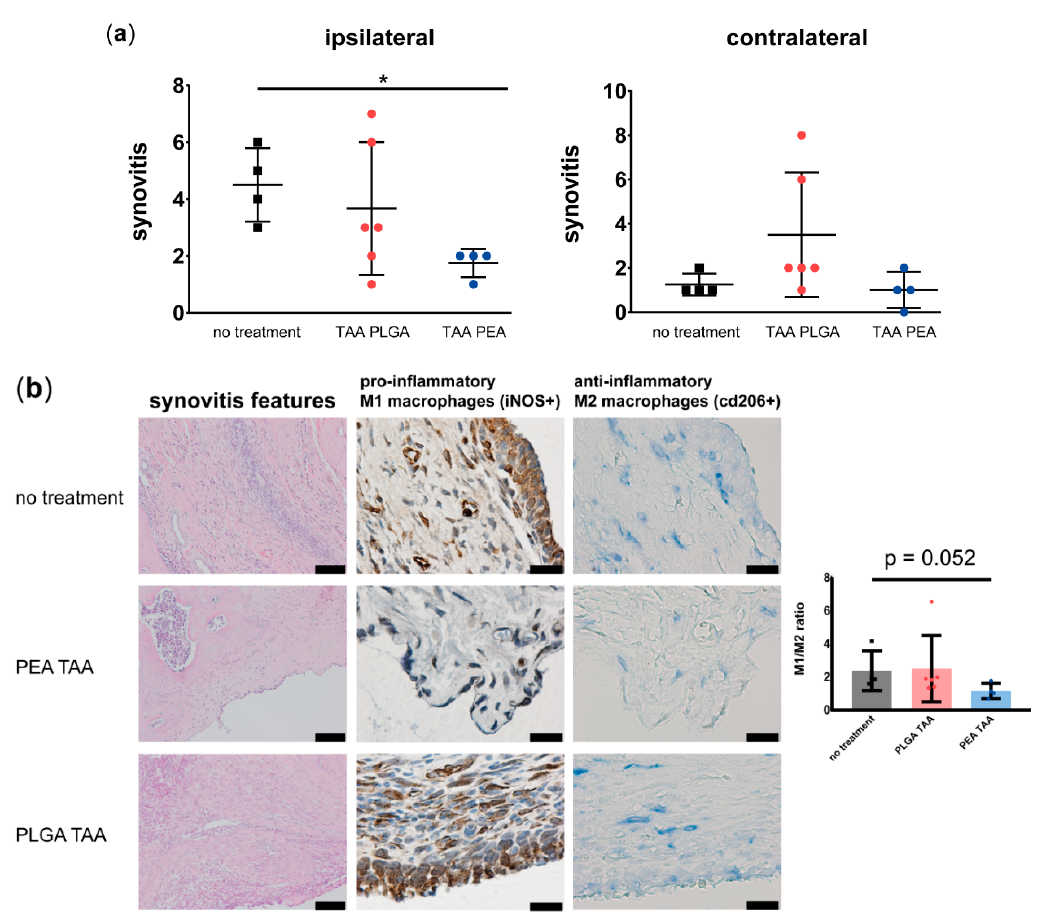
Figure 7. Histology and immunohistochemistry of untreated knee joints compared to joints treated with TAA-loaded PLGA microspheres and PEA microspheres. ( a ) Synovitis of affected knee joint (left